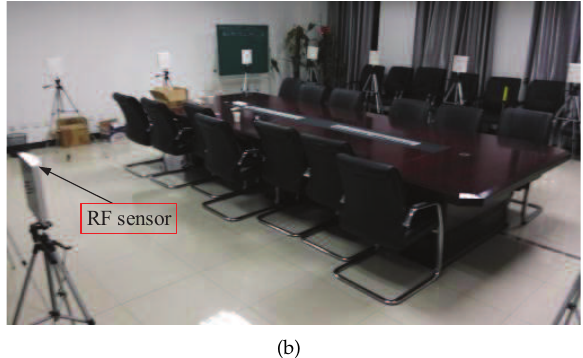
Figure 8. The indoor experimental environment: ( a ) a sketch of the experimental layout and ( b ) photography of the experimental